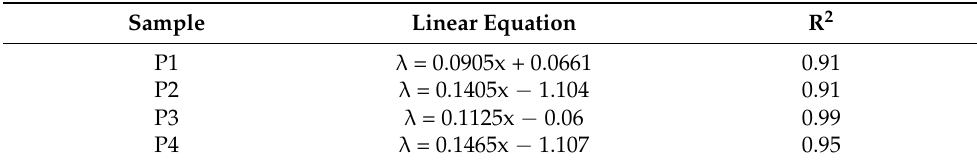
Figure 4. Correlation between the set airflow during combustion and the calculated λ coefficient . Table 3. Linear regression and correlation factors of the excess air coefficient and the set value of airflow .